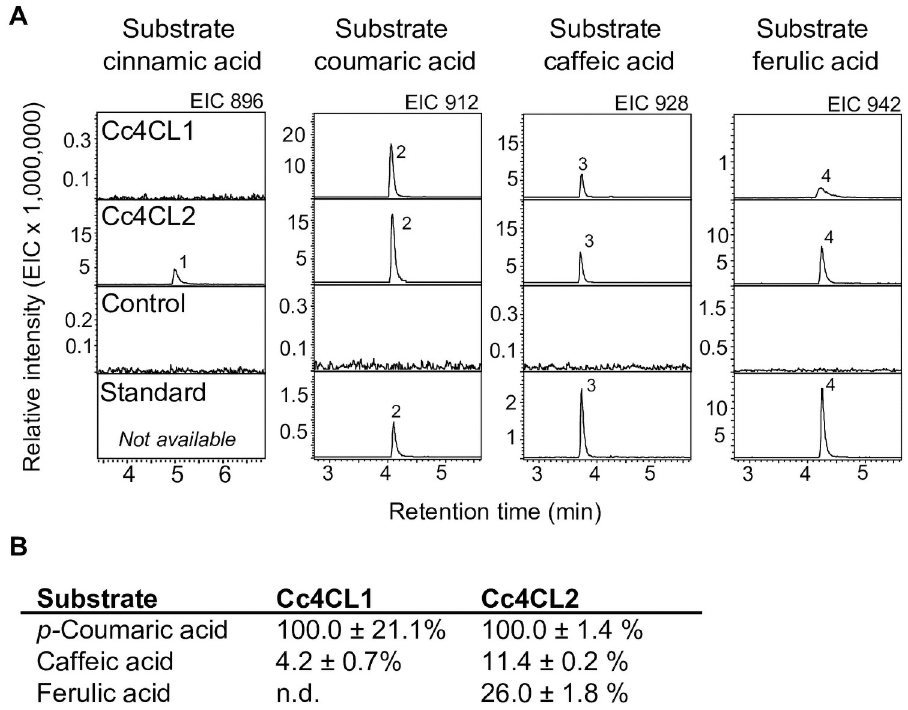
Fig 4. Enzyme activities of Cc4CL1 and Cc4CL2. (A) LC-MS product profiles. Enzymes were heterologously expressed in E . coli and Ni-purified protein was assayed with ATP, MgCl 2 , CoA, and one of the hydroxycinnamic acids, cinnamic acid, coumaric acid, caffeic acid, or ferulic acid. As controls, assays were performed with purified protein extracts of E . coli transformed with the empty vector. Products were analyzed using LC-MS and extracted ion chromatograms (EIC) are shown. Peak 1, tentatively identified as cinnamoyl-CoA (m/z 896); peak 2, coumaroyl-CoA (m/z 912); peak 3, caffeoyl-CoA (m/z 928); peak 4, feruloyl-CoA (m/z 942). n.d. not detected. (B) Relative product formation in competition assays. Cc4CL1 or Cc4CL2 were assayed with a combined set of the three hydroxycinnamic acid substrates, coumaric acid, caffeic acid and ferulic acid, in one reaction. The 100% activity value was defined by the substrate that yielded the most abundant product in the competition